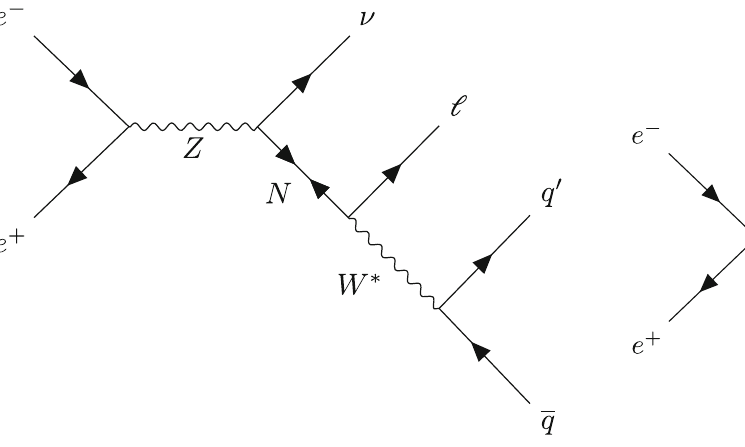
Fig. 1 The Feynman diagram of the signal process, with (cid:3) = e ,μ and ν summing over three active neutrino flavors